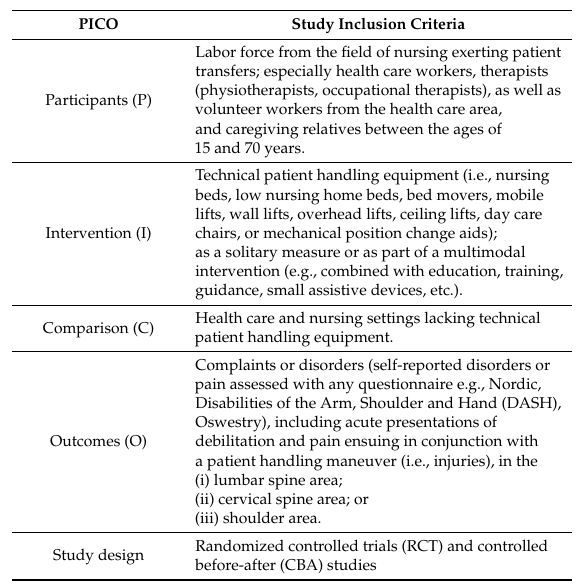
Table 1. Study inclusion criteria according to the PICO